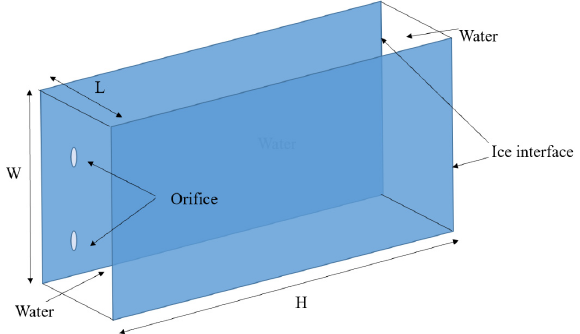
Figure 1. Schematic diagram of the simulation unit for modeling.